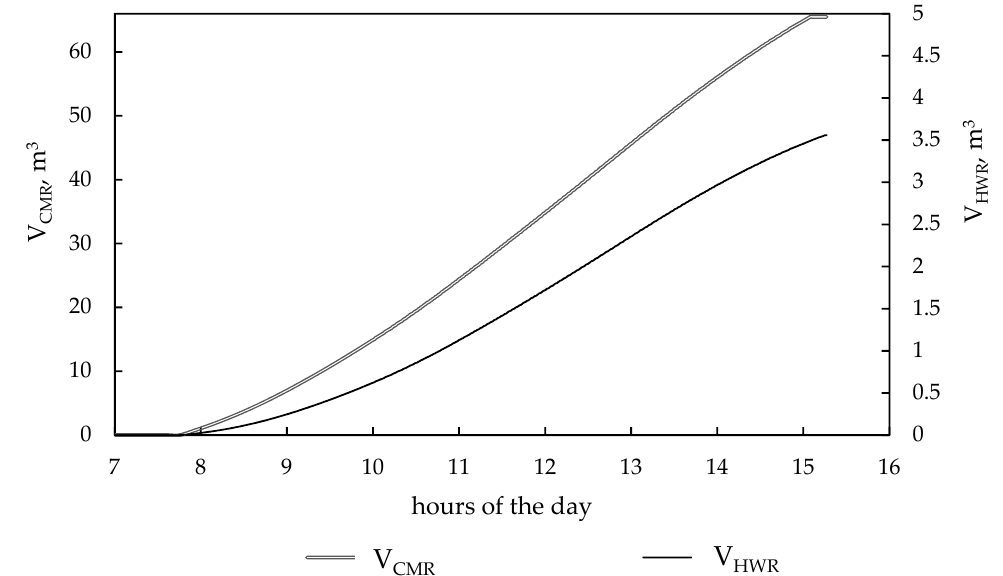
Figure 6. Off-design simulation of the charging phase (Reference day of May in Crotone)—volume increase in the storage sections: HWR (V HWR ) and CMR (V CMR ).